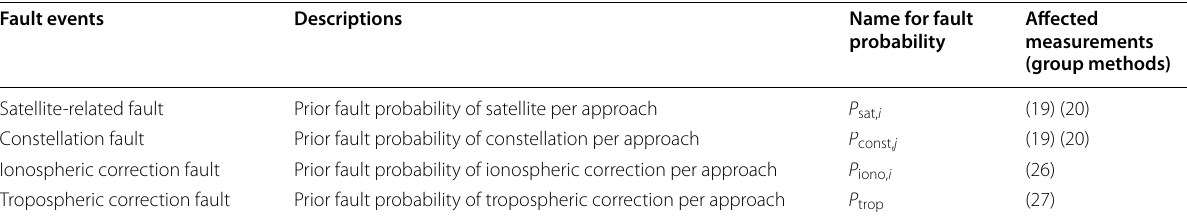
Table 2 Fault models for different measurements Fault